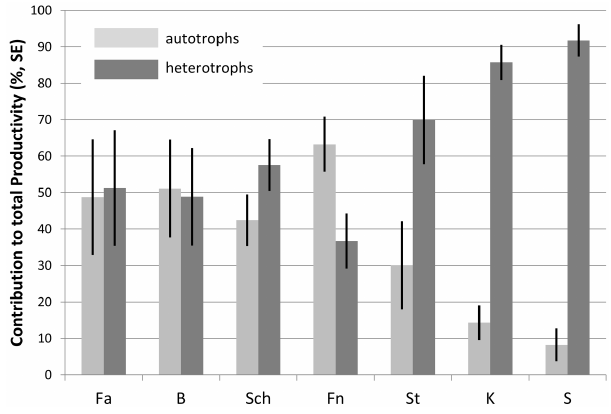
Fig. 8. Mean relative contribution of macroalgae (autotrophs) and sessile animals (heterotrophs) to the total annual productivity (% cover per panel) of a panel community (averaged over all panels and years for each station).